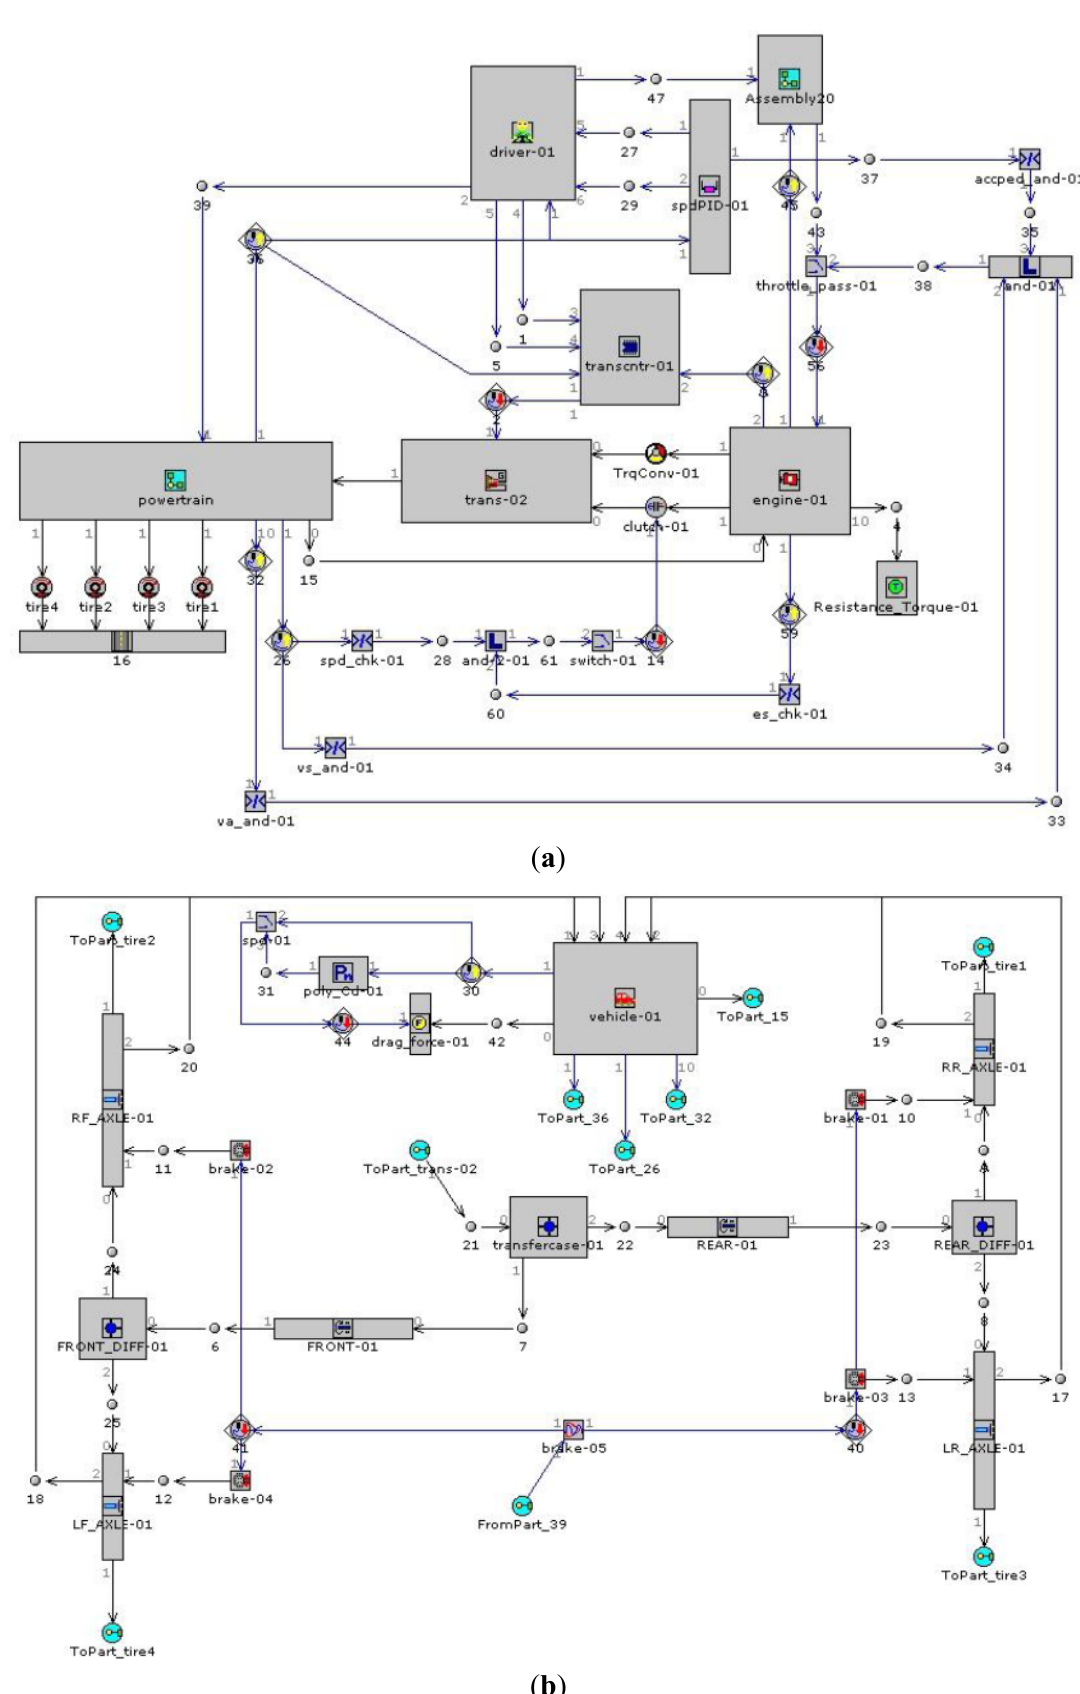
Figure 3. GT-Drive model of the conventional LMTV truck. ( a ) Powertrain model; ( b ) Vehicle